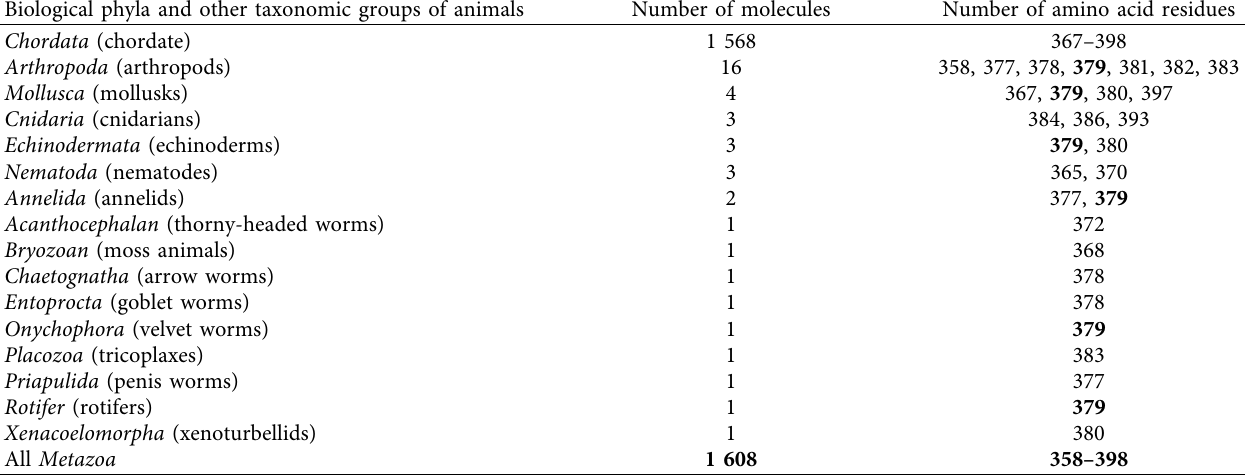
Figure 3: Distribution of the number of cytochrome b molecules, according to data from the Swiss-Prot database on the number of amino acid residues in various biological kingdoms. The data for animals are presented at two scales of the ordinate—a truncated one, revealing small peaks throughout the entire region where lengths of amino acid residues exist, and a full one, where the entire maximum peak of the distribution is visible. Table 3: Content of the number of cytochrome b amino acid sequences in the Swiss-Prot database in various biological phyla of animal ( Metazoa )